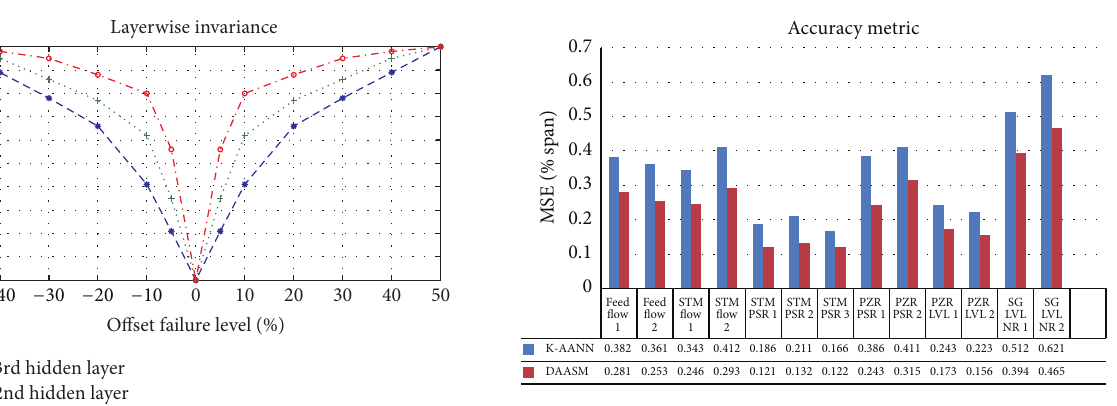
Figure 9: MSE depicting DAASM and K-AANN accuracy on each sensor.